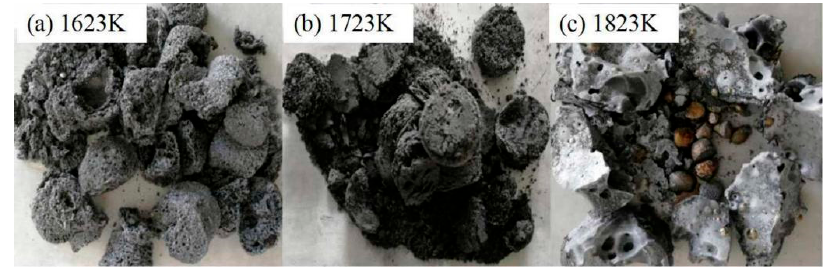
Figure 4. The reduced slag at ( a ) 1623 K, ( b ) 1723 K, and ( c ) 1823 K with 3% CaF 2 .